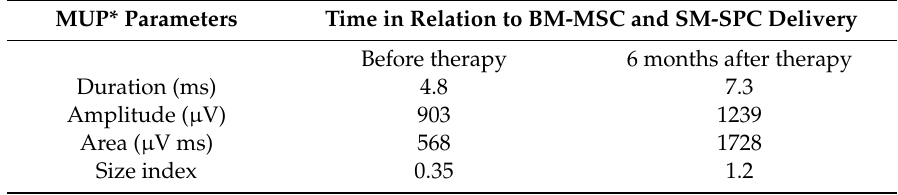
Table 5. Electromyographyexamination of Patient 3; MUP parameters of the biceps brachii muscle. MUP*